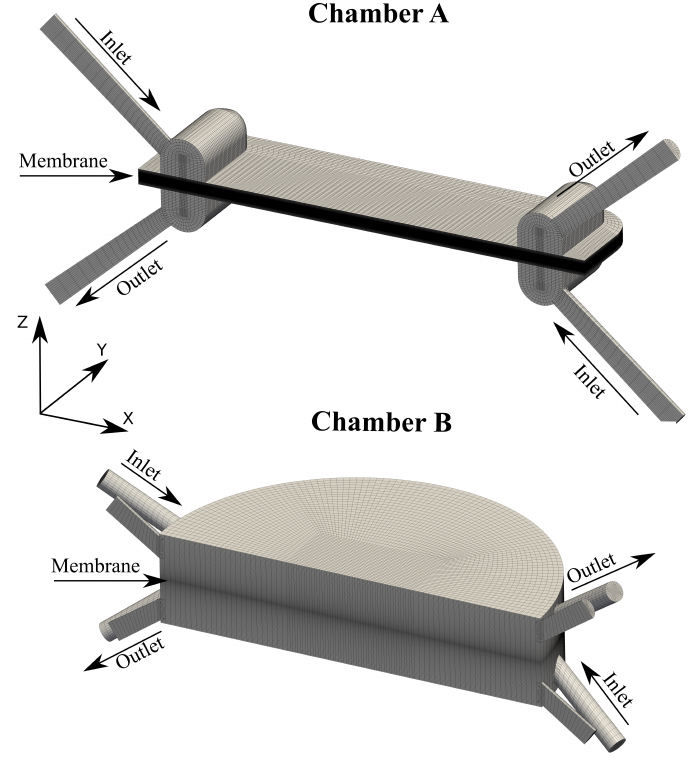
Figure 1. The computational meshes for the two flow chambers used in simulations. These represent the geometries of the chambers used in experiments. The membranes are modeled as planes in the middle of the chambers, lying in the symmetry-planes normal to the Z